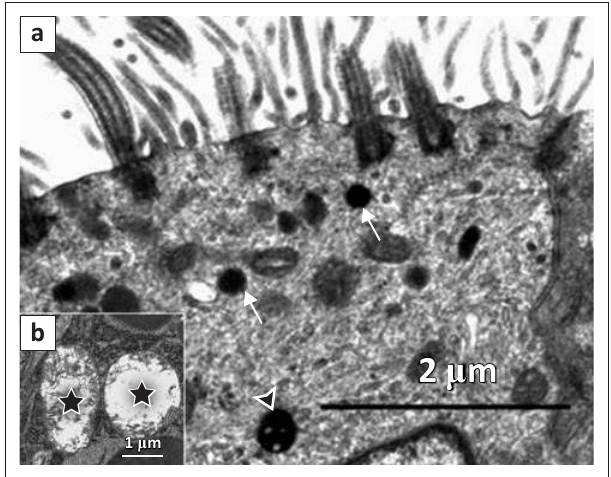
FIGURE 7: Transmission electron photomicrographs of the magnum from a control bird.